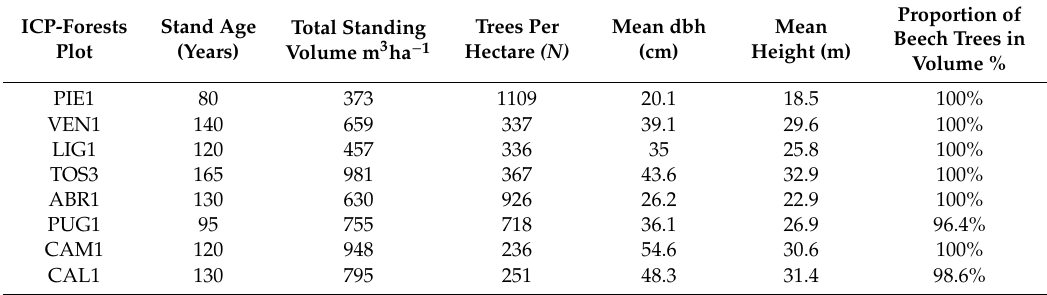
Table 1. Main mensurational variables of beech plots at the last survey (2015) in Italy. ICP-Forests Plot